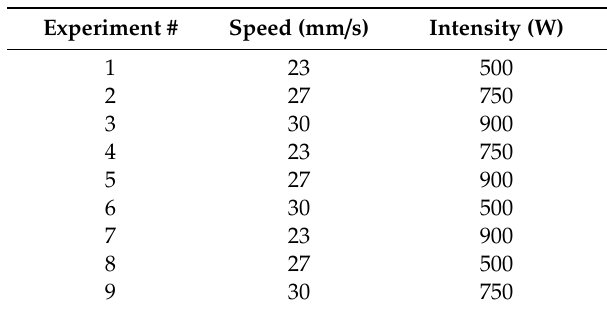
Table 3. Combinations for line